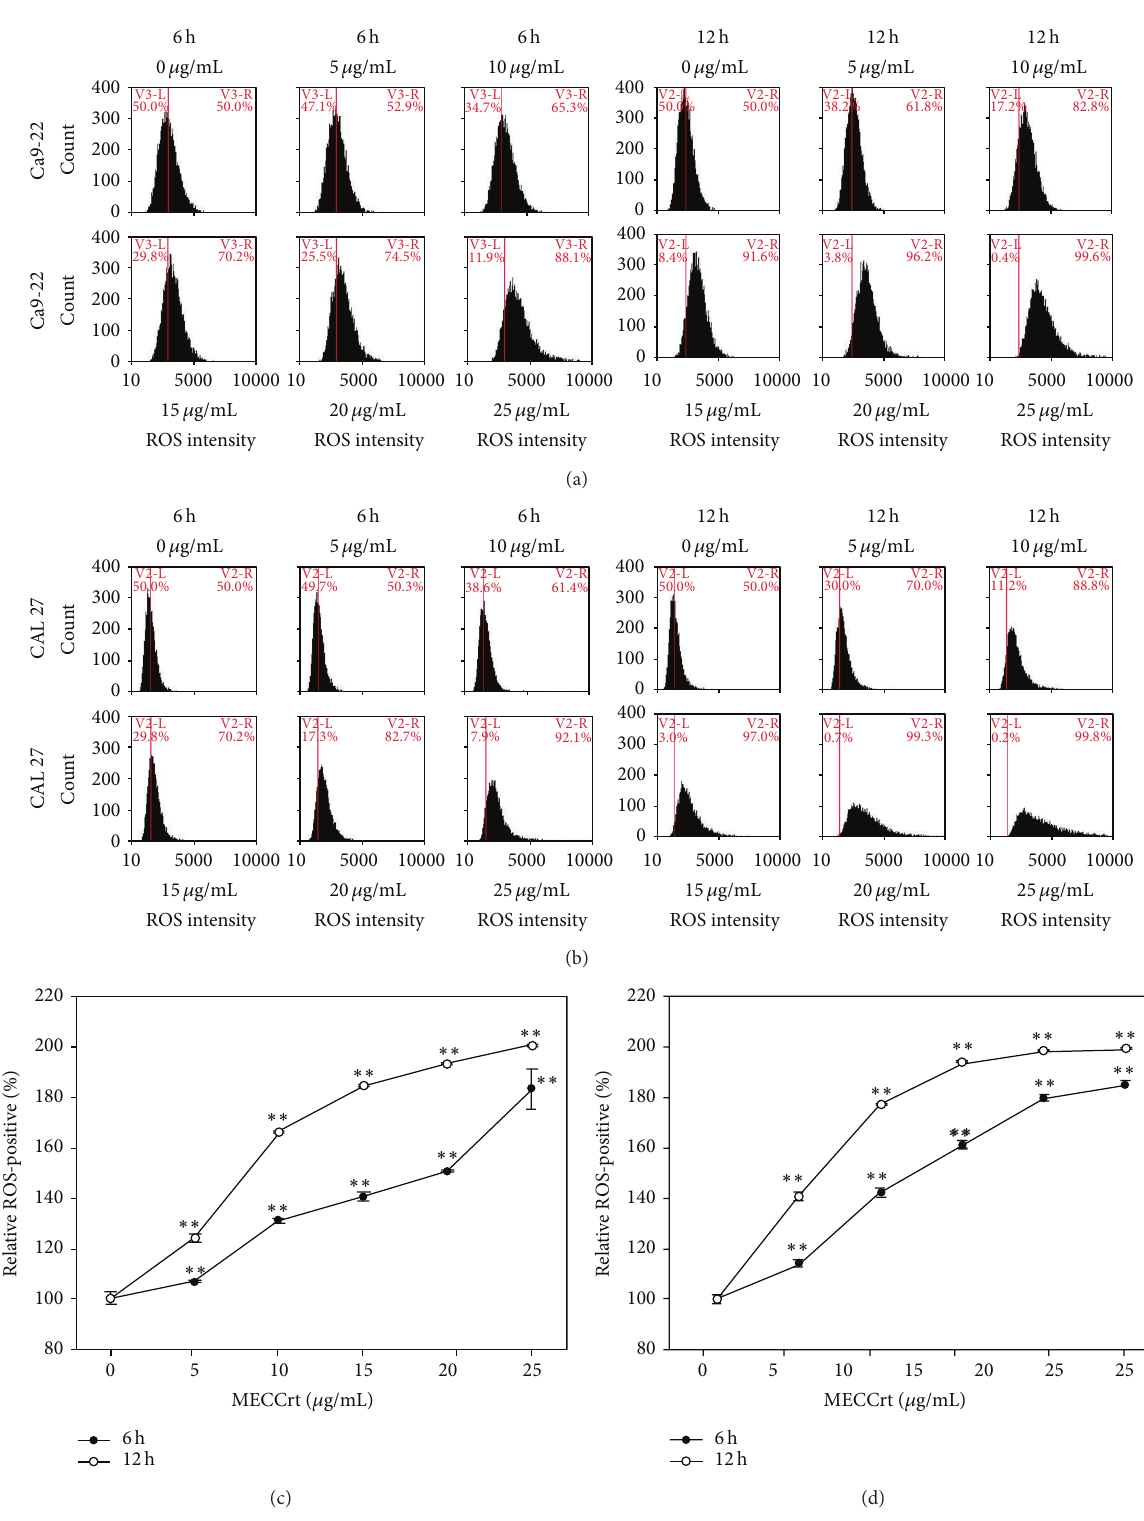
Figure 4: Reactive oxygen species (ROS) generation of two oral cancer cell lines was induced by MECCrt. Oral cancer Ca9-22 and CAL 27 cell lines were treated with different concentrations (0–25 𝜇 g/mL) of MECCrt for 6 and 12 h. ((a), (b)) Representative ROS profiles of flow cytometry for MECCrt-treated oral cancer Ca9-22 and CAL 27 cell lines. ((c) and (d)) Statistics analysis of relative ROS intensity in (a) and (b), respectively. Data, means ± SDs ( 𝑛 = 3 ). ∗∗ 𝑃 < 0.01 against